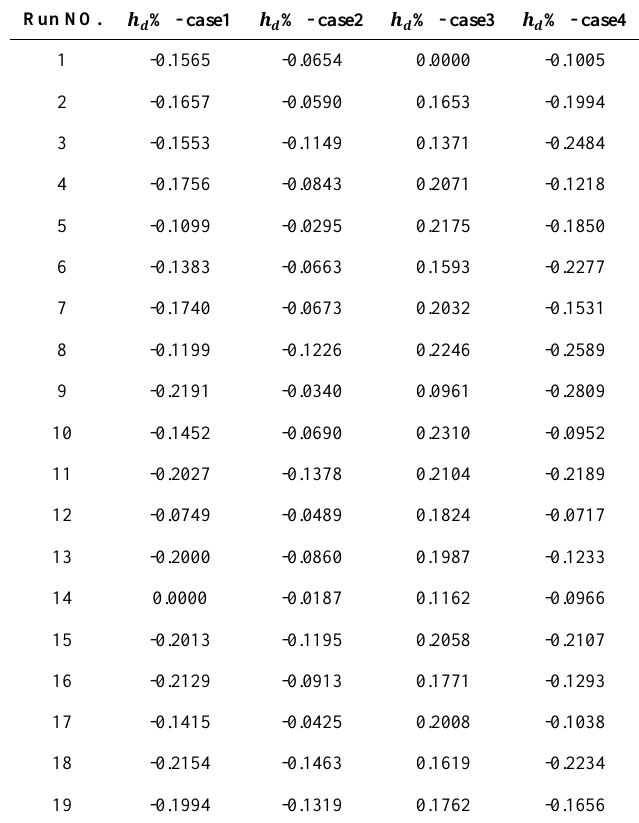
Table 3. Average downstream water depth percentage of increase or decrease Run